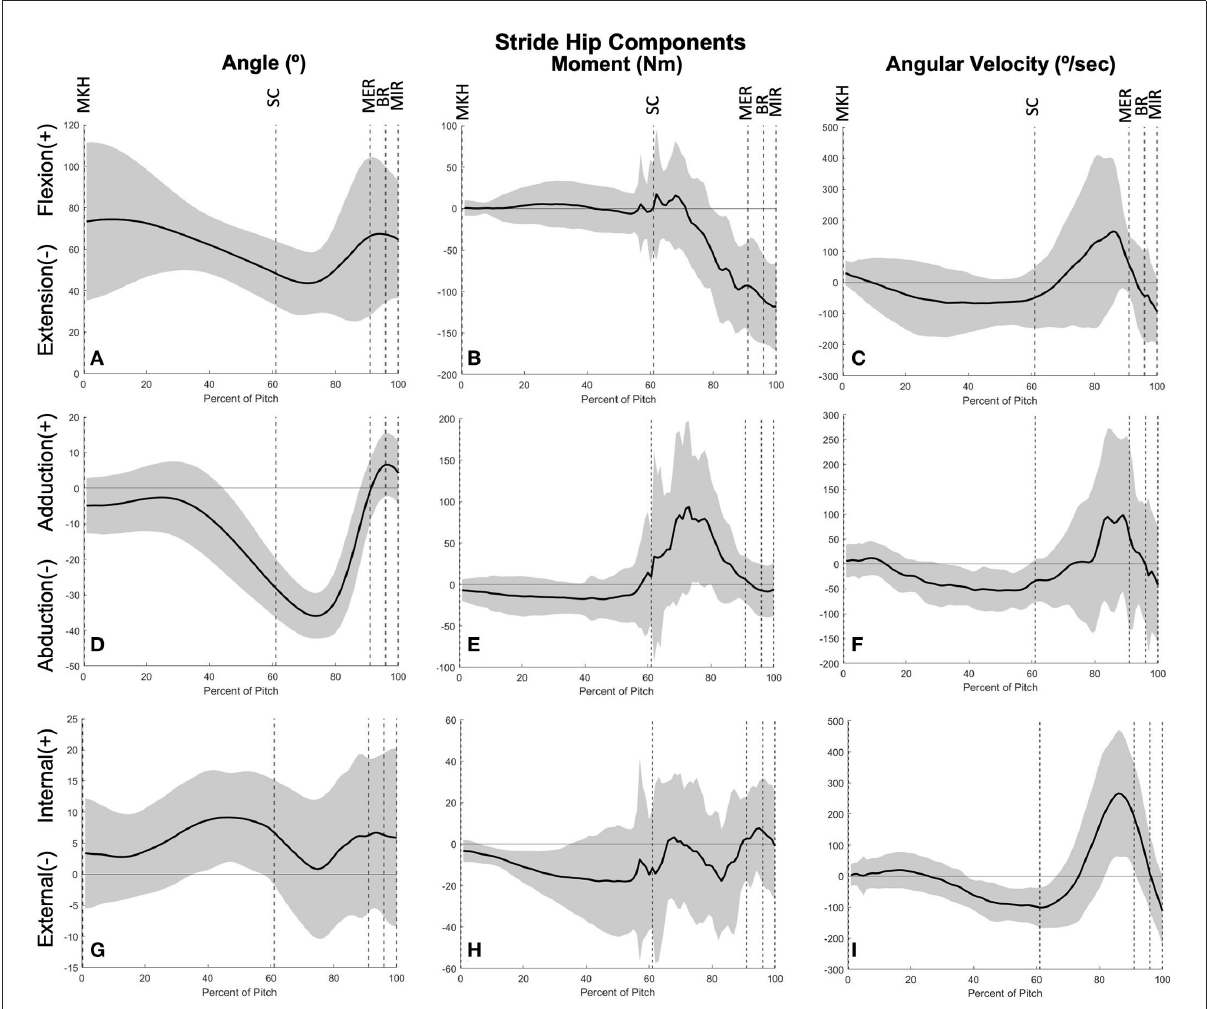
FIGURE9 Mean ± SD joint angle, joint moment, and joint angular velocity for the stride hip in extension/flexion (A–C) , ab/adduction (D–F) , and internal/external rotation (G–I) for the duration of the pitch from maximum knee height (MKH) to maximum internal rotation